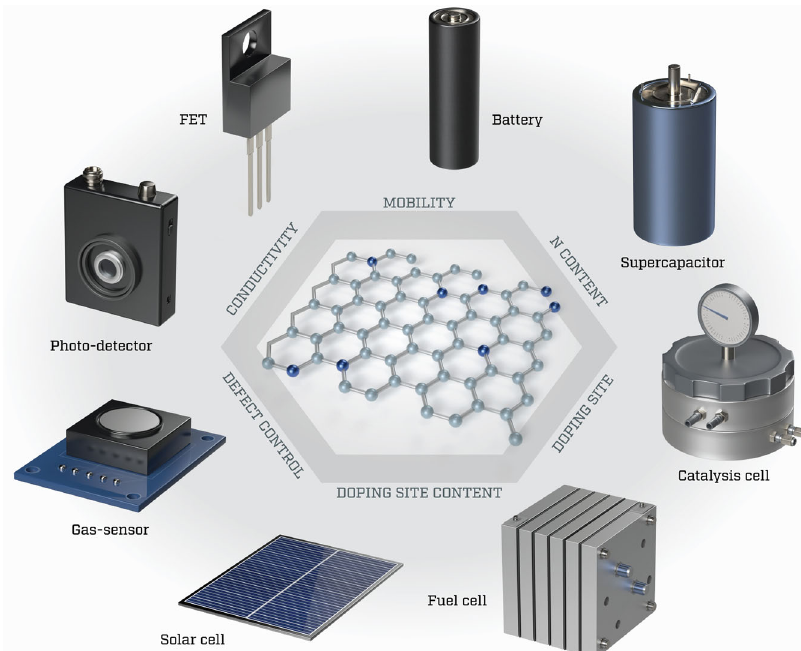
Fig. 1 Structure and applications of NDG. The gray hexagon in the center displays a molecular model of the N-doping con fi gurations in a graphene lattice (gray and blue denote C and N atoms, respectively). Surrounding the NDG model expresses the properties of NDG needed in applications. The outermost circles enclose typical NDG applications with representative images (e.g., the fi eld-effect transistor,